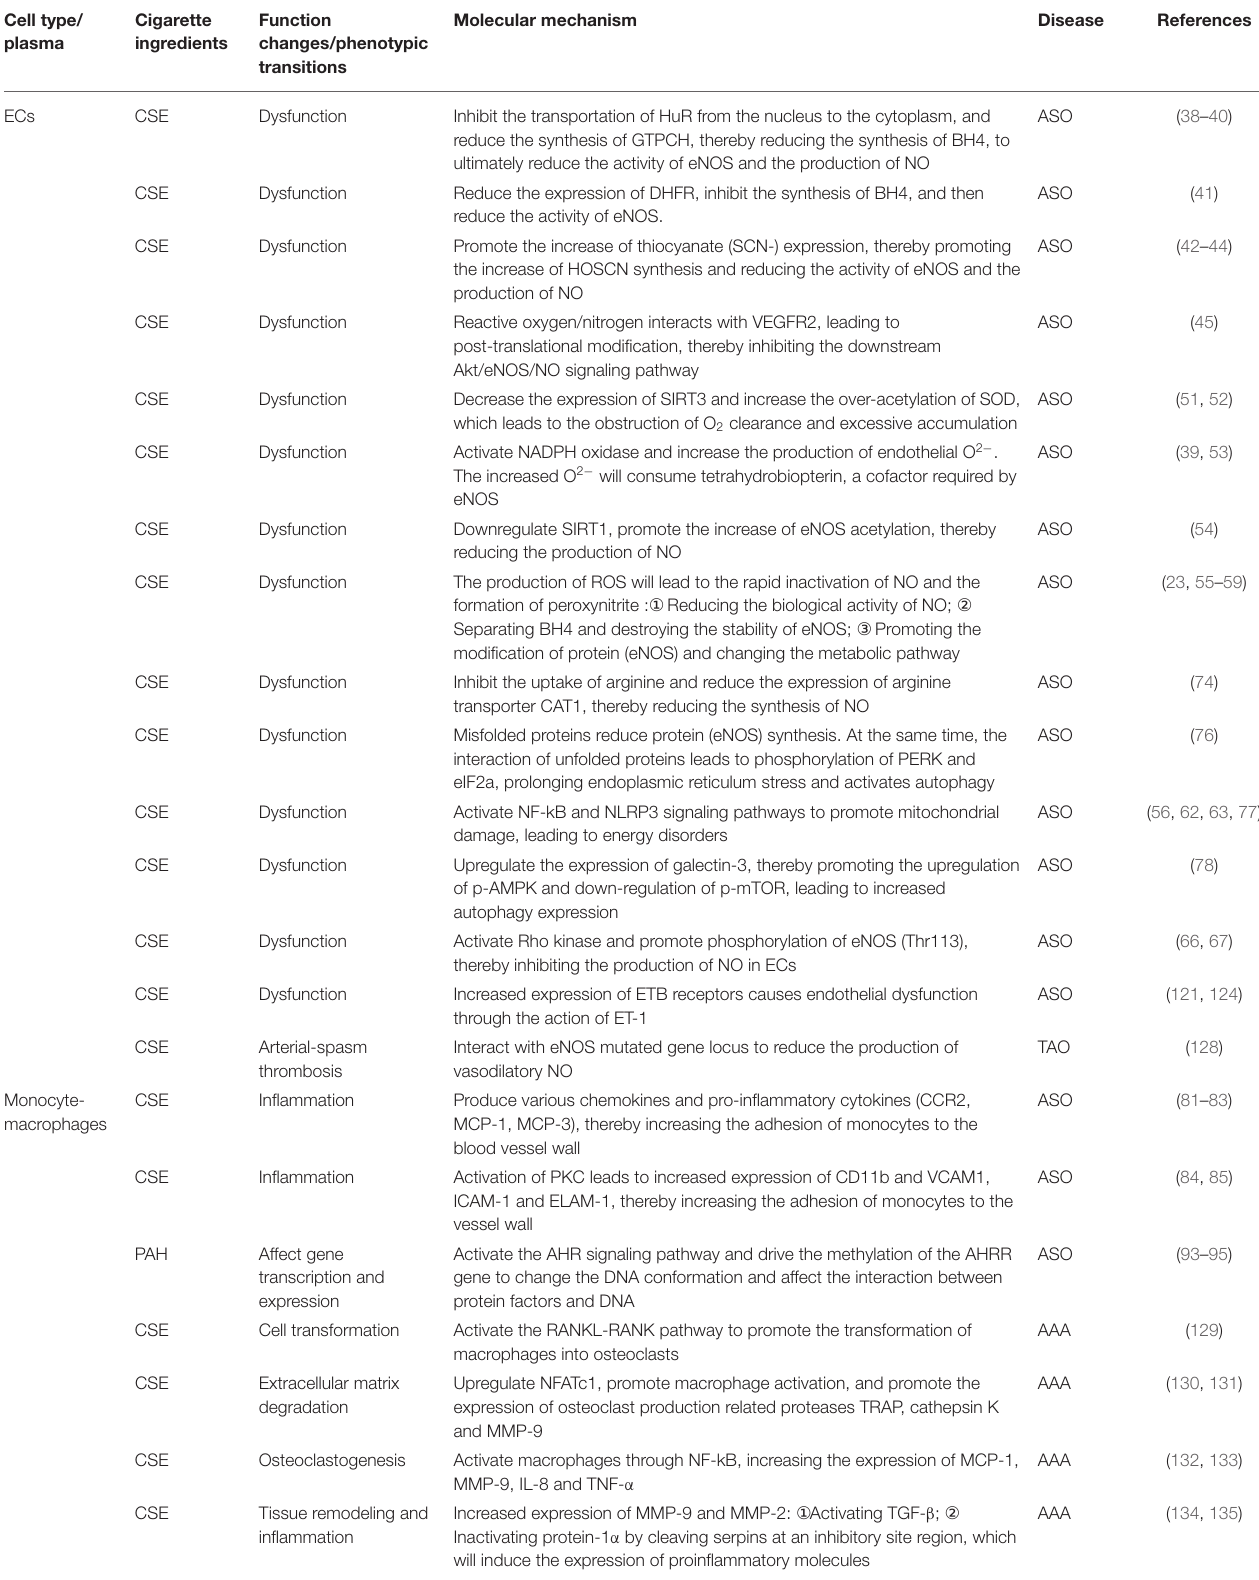
TABLE 1 | Smoking and various types of cell function changes, phenotypic transitions and their molecular mechanisms. Cell type/